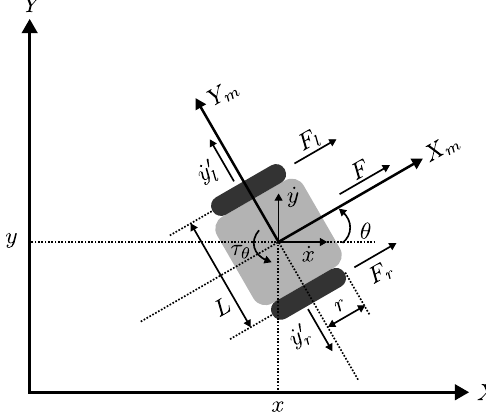
Figure 2. Diagram of forces, torques, and non-holonomic constraints of the differential mobile